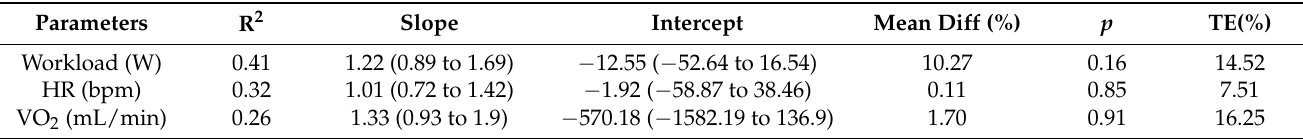
Table 1. Agreement with gold standard (RQA vs. GEx) for Workload (Watt), HR (bpm), and VO 2 (mL/min) value.